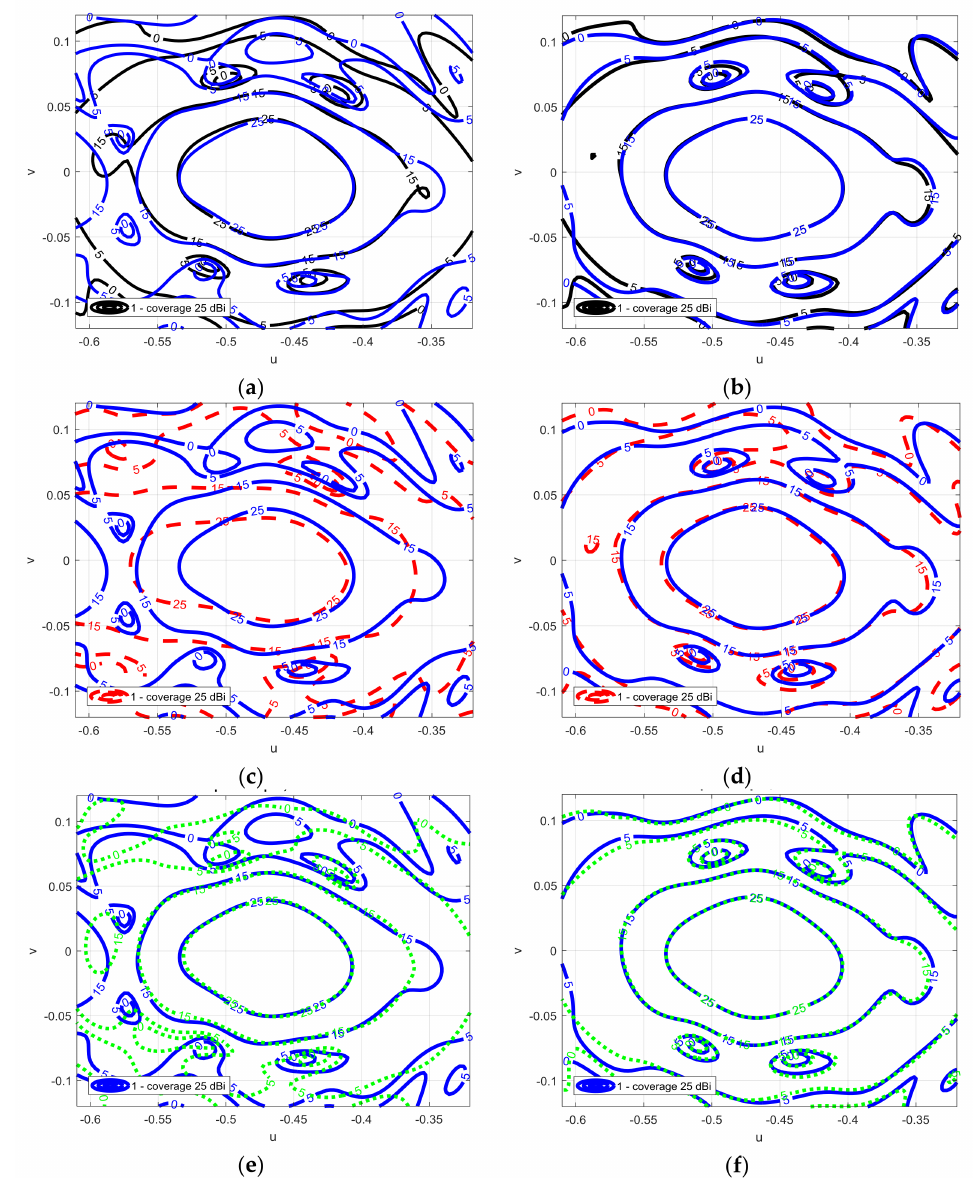
Figure 4. ( a ) Contour plots of the copolar components of the radiation pattern full wave analysis (solid blue line (-)) and approximate case (dashed black line (–)) vertical polarization; ( b ) for horizontal polarization. ( c ) Contour plots of the copolar components of the radiation pattern simulated for the full wave analysis (solid blue line (-)) and the more general approach dividing the SRA in 9 (dashed dot red line (-)) for vertical polarization and ( d ) for horizontal polarization. ( e ) Contour plots of the copolar components of the radiation pattern simulated for the full wave analysis (solid blue line (-)) and the more general approach dividing the SRA in 25 (dashed green line (:)) for vertical polarization and ( f ) for horizontal